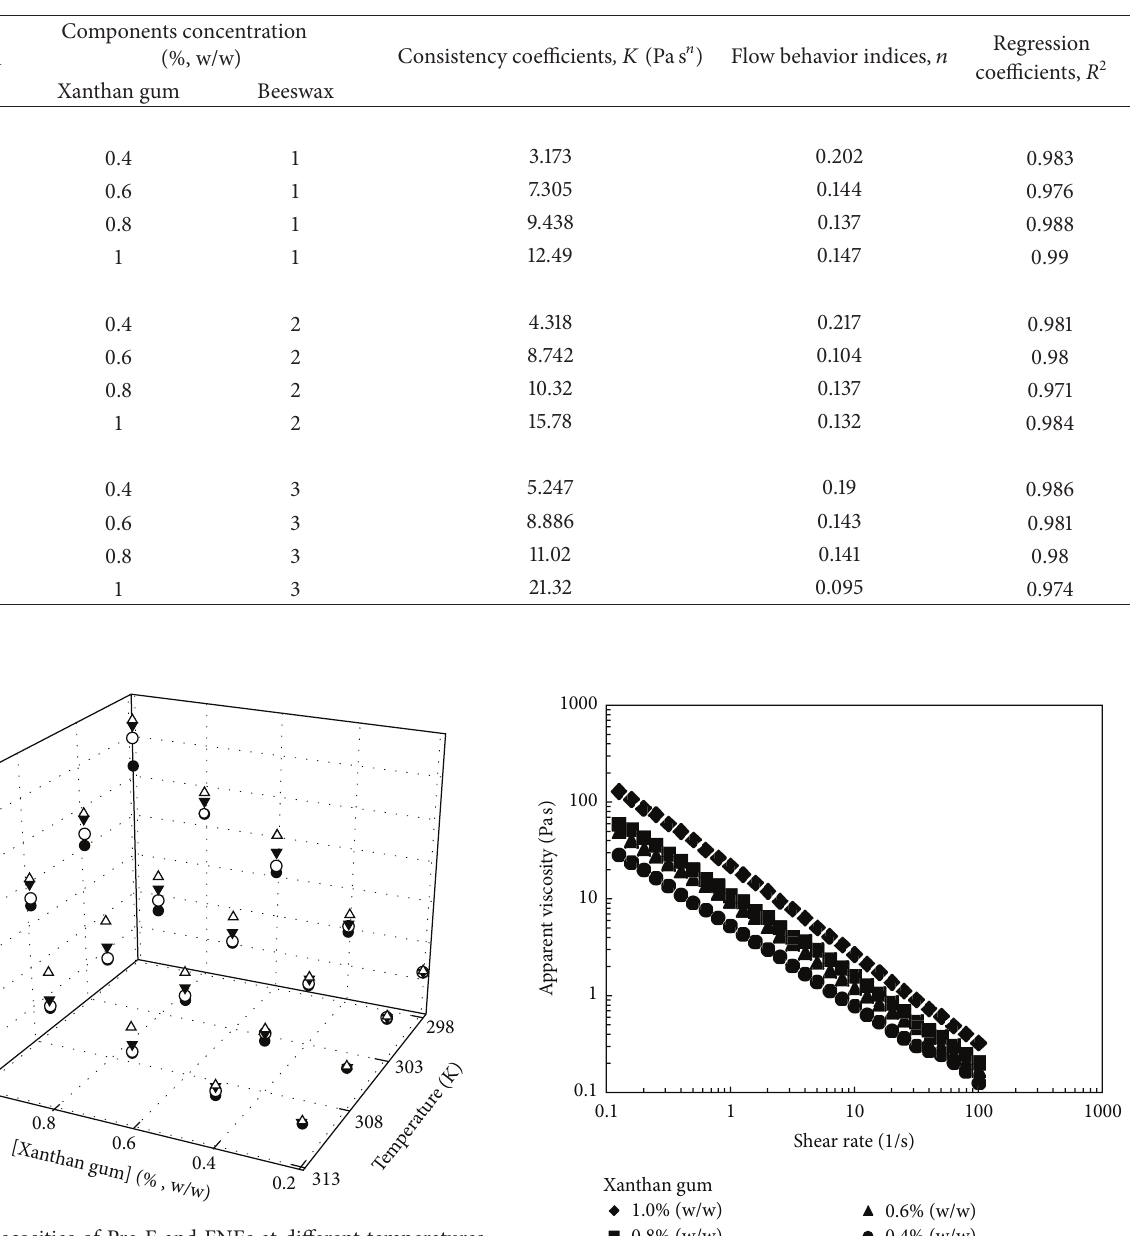
Table 4: Power law model parameters for selected FNE formulations.